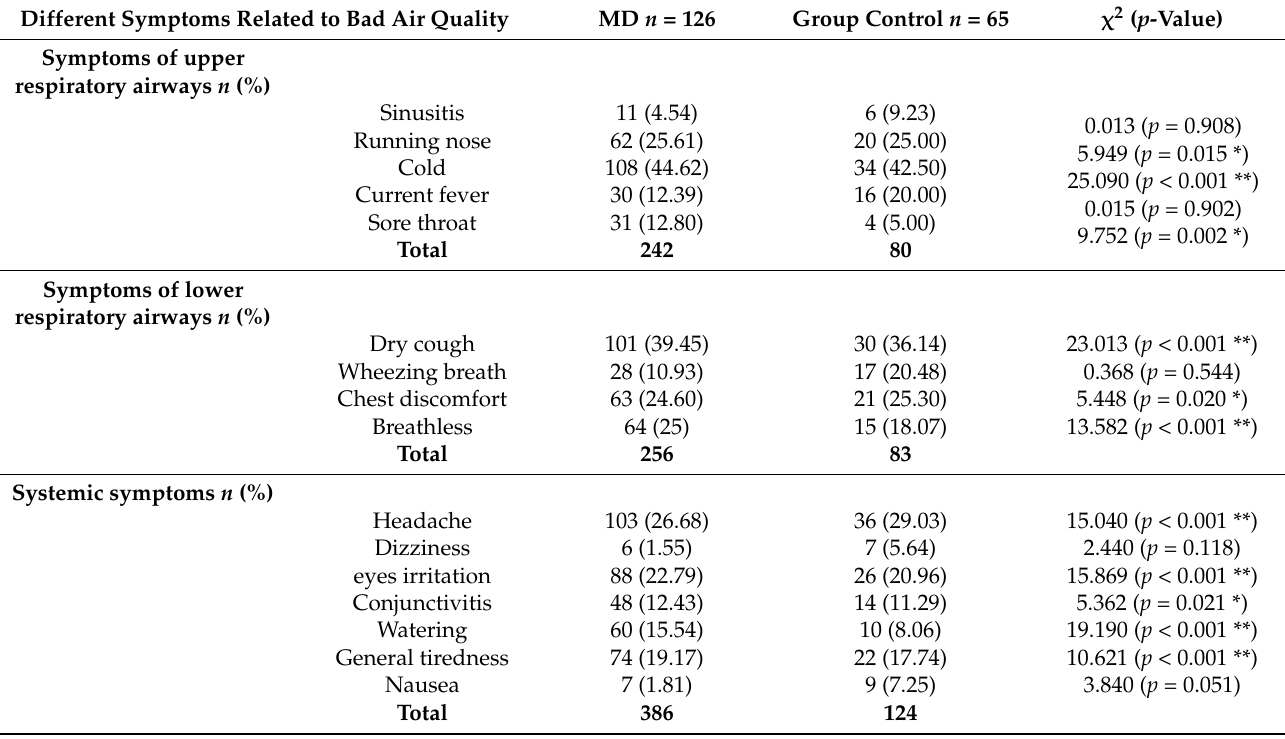
Table 4. Distribution symptoms among motorbike drivers and group control selected for nested study. Different Symptoms Related to Bad Air Quality